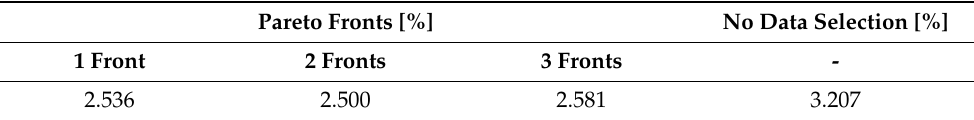
Table 12. MAPE values for Pareto fronts and ‘no data selection’ models for the sixth verification case. Pareto Fronts [%]